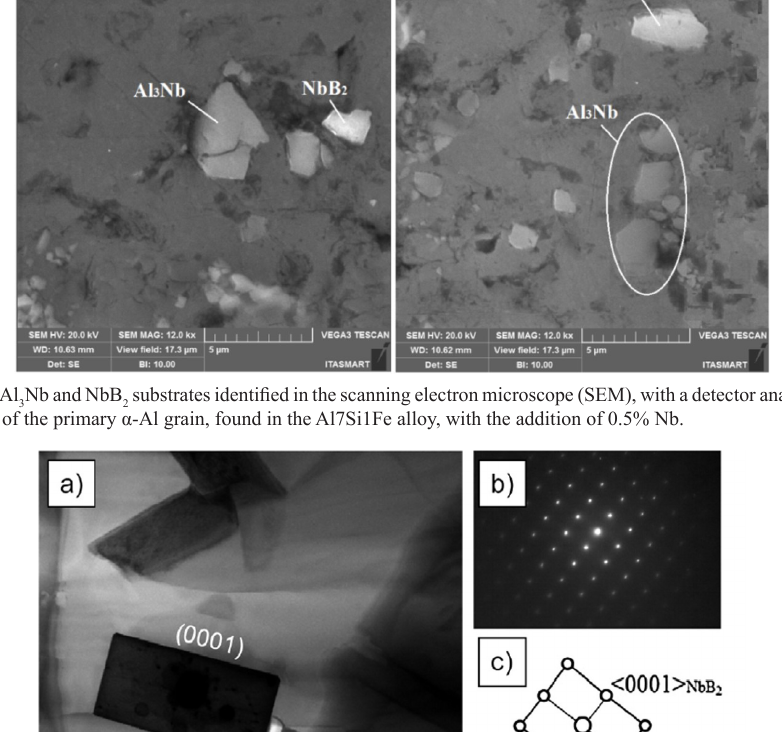
substrate, and (b, c) diffraction pattern of NbB 2